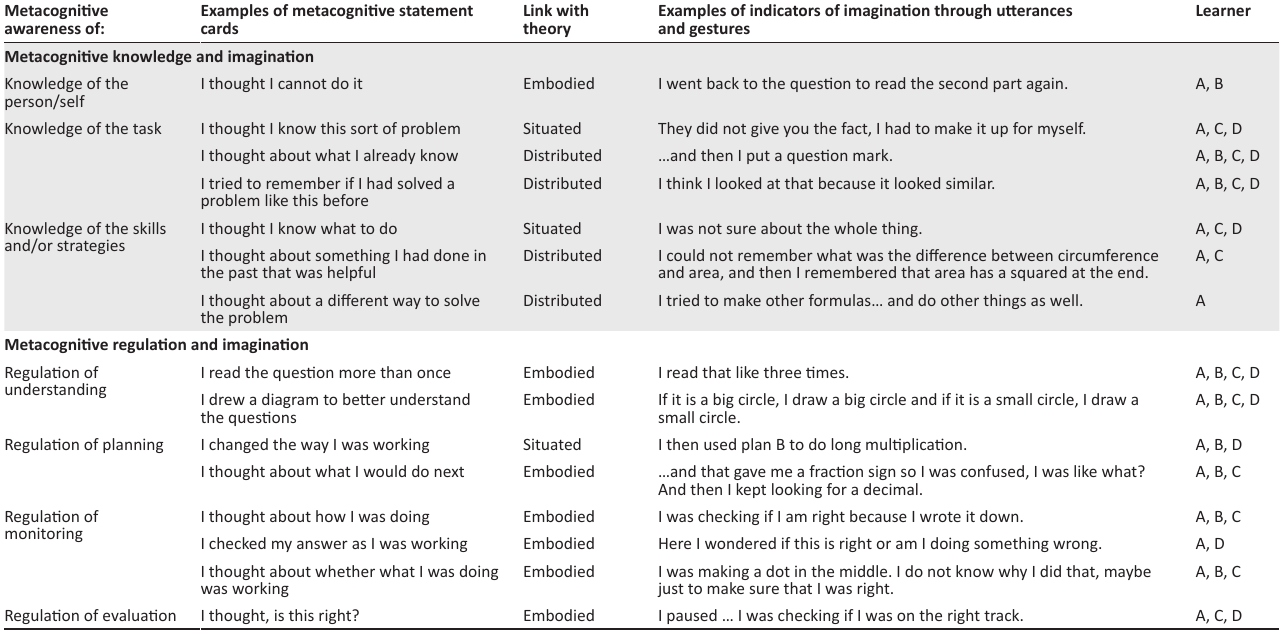
TABLE 1: Summary of findings that reflect the tenets of metacognitive awareness and imagination. Metacognitive awareness